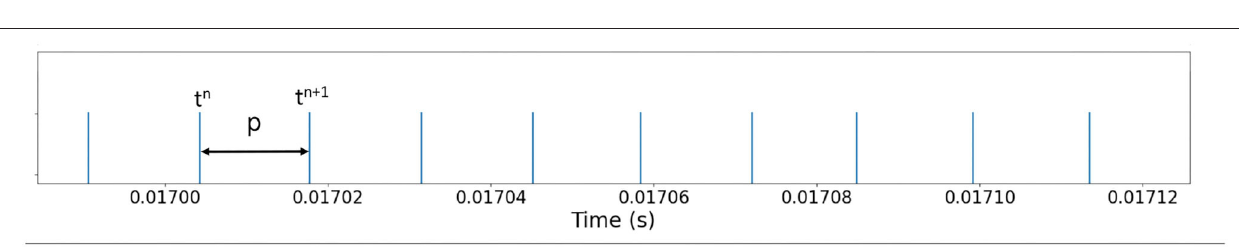
FIGURE 1 | Neuromorphic filter architecture, showing a spiking neuron CMOS circuit implementation, see Wu et al. (2015).